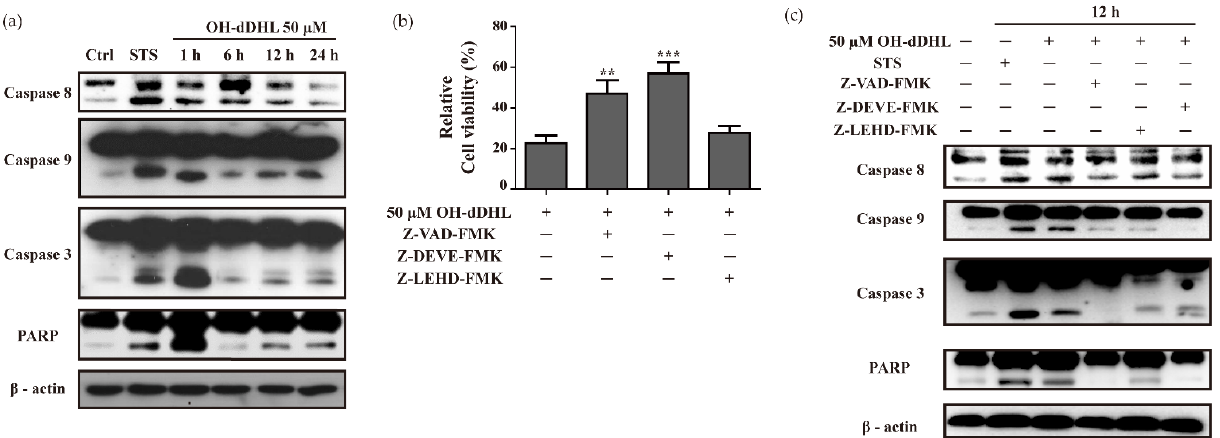
Figure 3. OH-dDHL-induced caspase activation. ( a ) BMDMs were treated in a time-dependent manner. Staurosporine (STS) was used as a positive control. Caspase-8, -9, and -3, and PARP were analyzed using Western blot. Ctrl; negative control. ( b ) Caspase inhibitor 30 µM Z-VAD-FMK, 40 µM Z-DEVE-FMK, 30 µM Z-LEHD-FMK pretreated BMDMs were treated with 50 µM OH-dDHL and cell viability was measured with CCK assay. Data are presented as means ± SEM of three independent experiments. ***, p < 0.001, **, p < 0.01 vs. OH-dDHL. ( c ) Western blot of caspase-8, -9, and -3, and PARP in caspase inhibitor-pretreated BMDMs with 50 µM OH-dDHL.